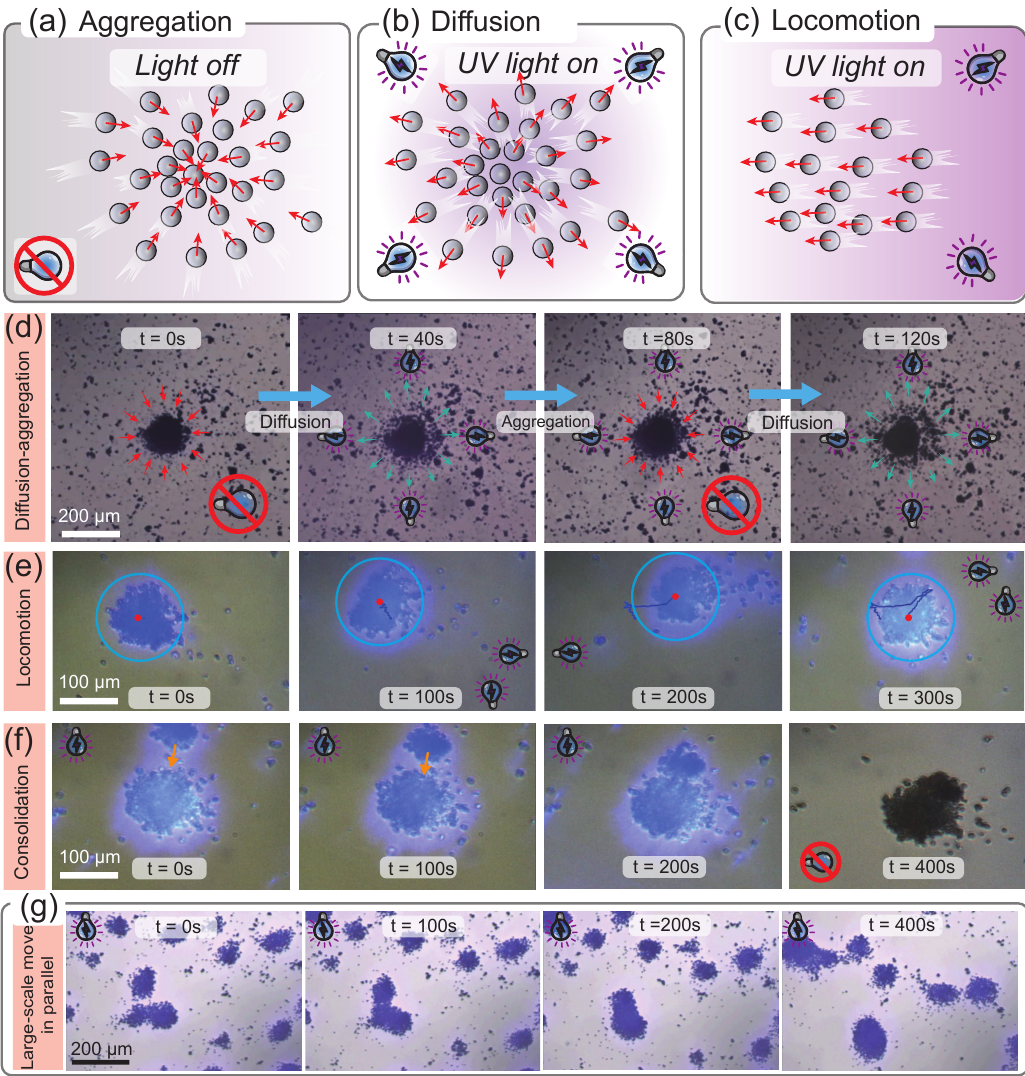
Figure 4. Collective behavior of TiO 2 microrobots under the action of multiple light fields. ( a ) Schematic diagram of self-aggregation of TiO 2 microrobots in the absence of light field. The red arrow indicates the direction of motion of the robot. ( b ) Scattering diagram of the TiO 2 microrobot swarm under UV light field. ( c ) Locomotion diagram of the TiO 2 microrobot swarm under directional UV light field. ( d ) Controllable aggregation and diffusion behavior of a large number of TiO 2 micro- robots under pulsed UV light. The blue arrow indicates the direction of progress. ( e ) Locomotion of TiO 2 microrobot swarms under the sequential control of the multi-light source platform. The blue circle and red dot represent the position of the swarm. ( f ) Merging process of TiO 2 microrobot swarms under multiple UV illuminations. Orange arrows indicate the direction of movement of the swarm. ( g ) Combined motion and merging of large-scale microrobot swarms under the control of the multi-light source platform in